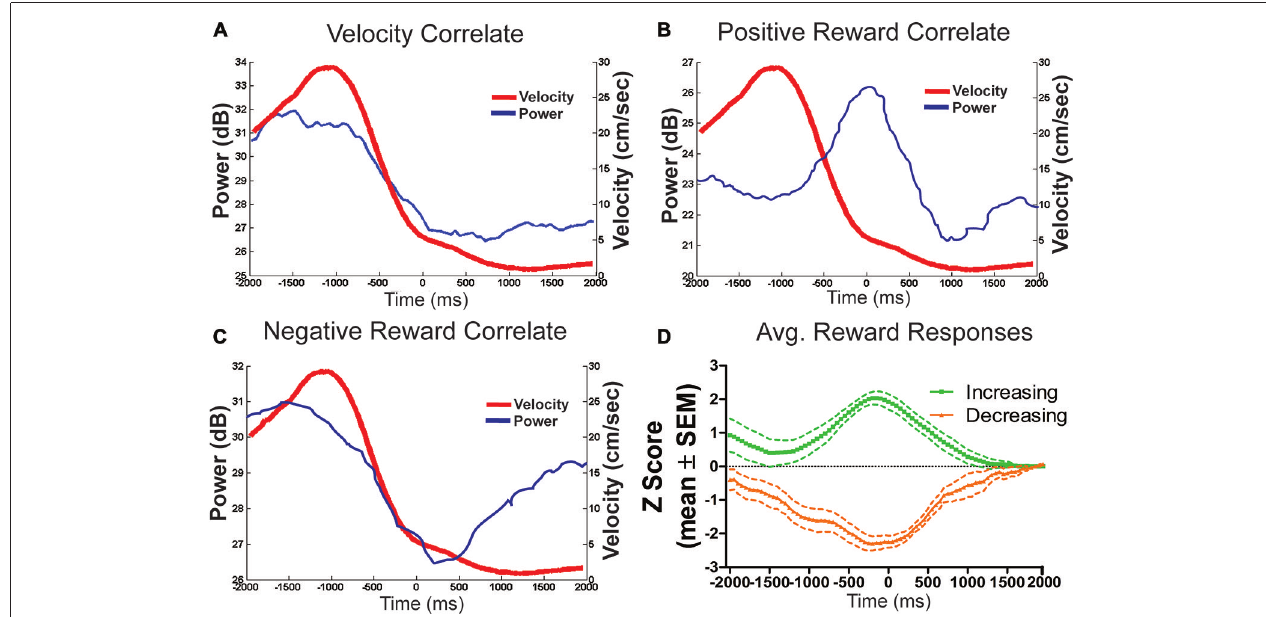
FIGURE 8 | Example theta power correlates and reward population responses. (A) An example of LFP theta power which correlated only with velocity ( r = 0.96). (B) An example of a positive reward approach only LFP theta channel. (C) Reward related signals were also equally likely to negatively respond to reward approach. (D) Shows the population average power converted to z -scores of all positively and negatively responding reward approach LFP theta signals.